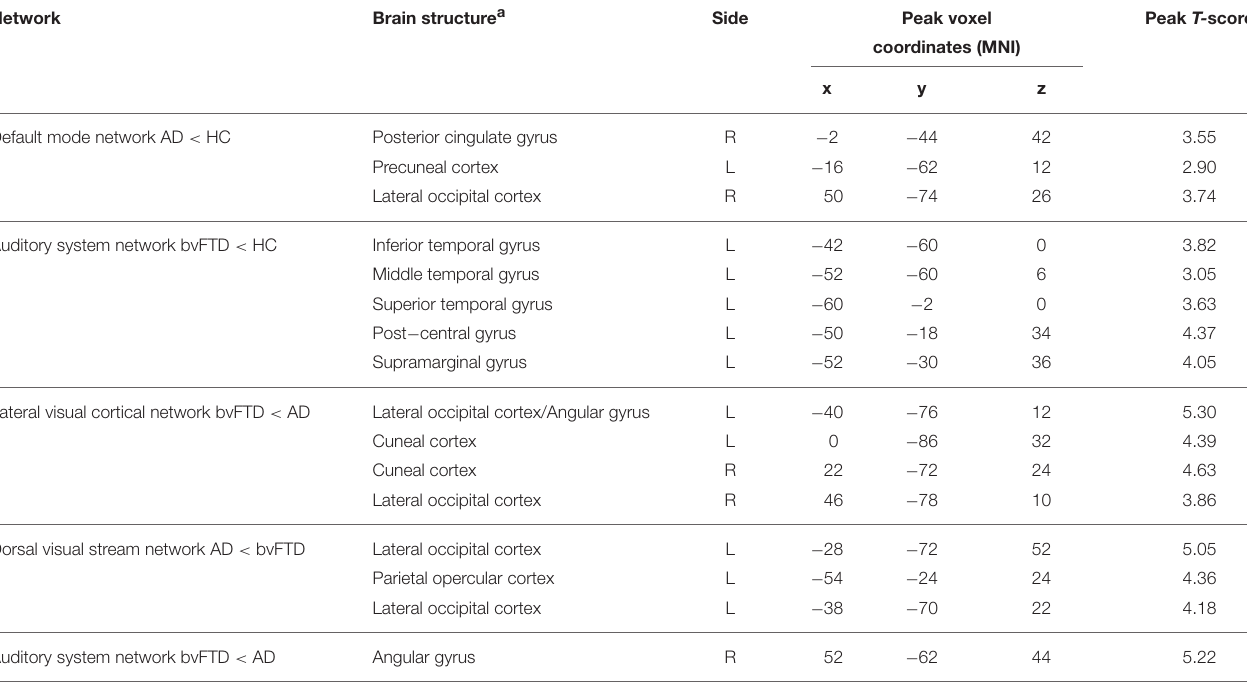
TABLE 2 | Group differences in network functional connectivity.